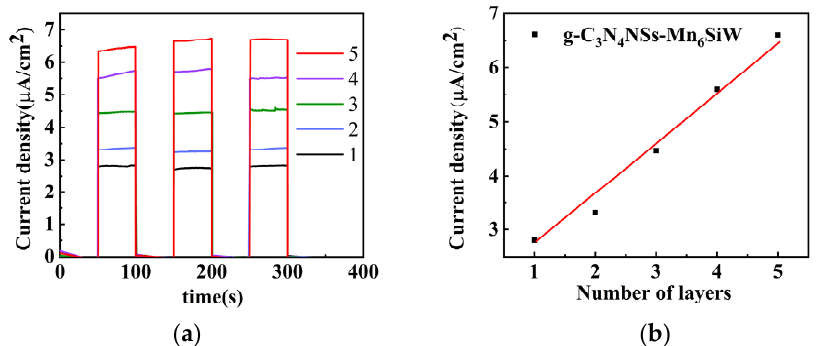
Figure 8. ( a ) Amperometric i–t curves of the PDDA/PSS/(g-C 3 N 4 NSs/Mn 6 SiW)n film ( n = 1–5) un- der incandescent lamp irradiation (450–650 nm); ( b ) the relationship between average of photocurrent and number of film electrode assembly layers.